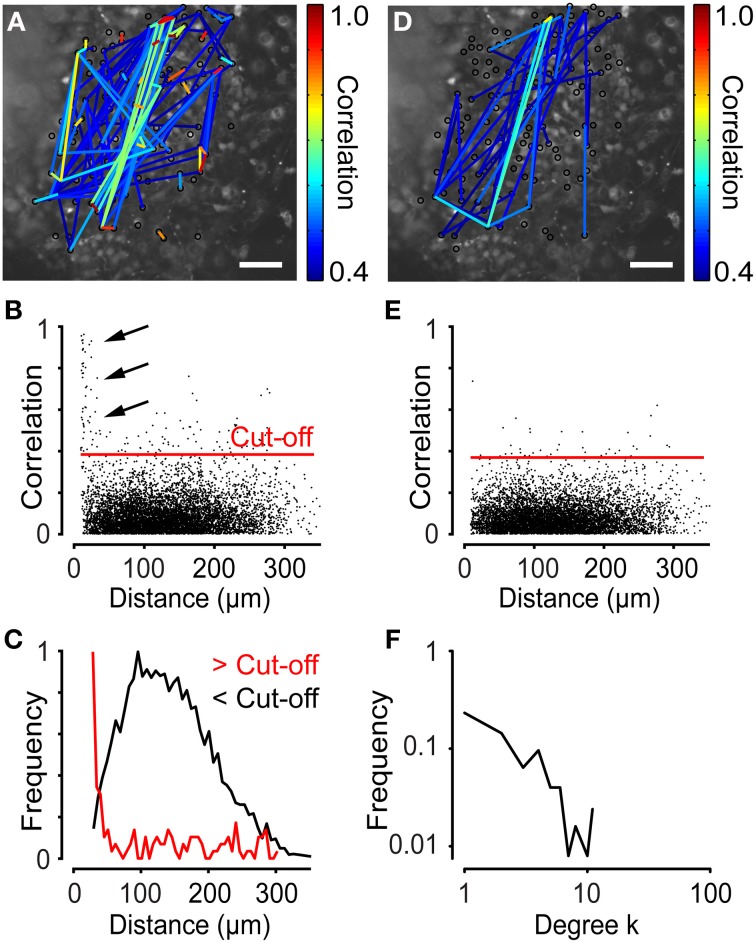
Network analyses performed on time-lapse Ca2+ recordings of neural progenitor cells. (A) Network with a cut-off of 0.39 for neural progenitor cells plotted on top of a microscopic image. (B) Correlation as a function of distance for the experiment shown in (A). Red line indicates the cut-off level. Arrows indicate cell pairs with high correlations and short intermodal distances. (C) Distance distribution of data in (B) with correlations above cut-off (>Cut-off), shown in red, and below cut-off (<Cut-off), shown in black. Note the higher frequency of shorter distances for correlations above the cut-off. (D) Network plot of data from (A) scrambled in time domain, as described in Figure 3. (E) Correlation as a function of distance for the data shown in (D). (F) Degree distribution of the analysis on neural progenitor cells showed in (A). Scale bars, 50 μm.